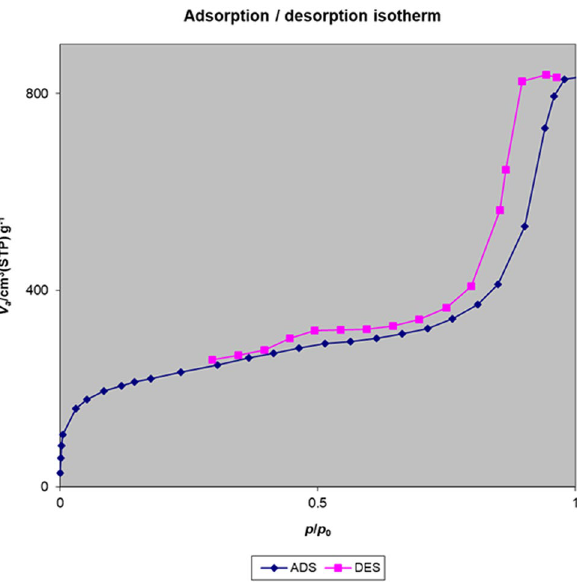
Figure 10. Nitrogen adsorption–desorption isotherm of the Fe 3 O 4 @Void@m.SiO 2 nanomaterial before adsorption